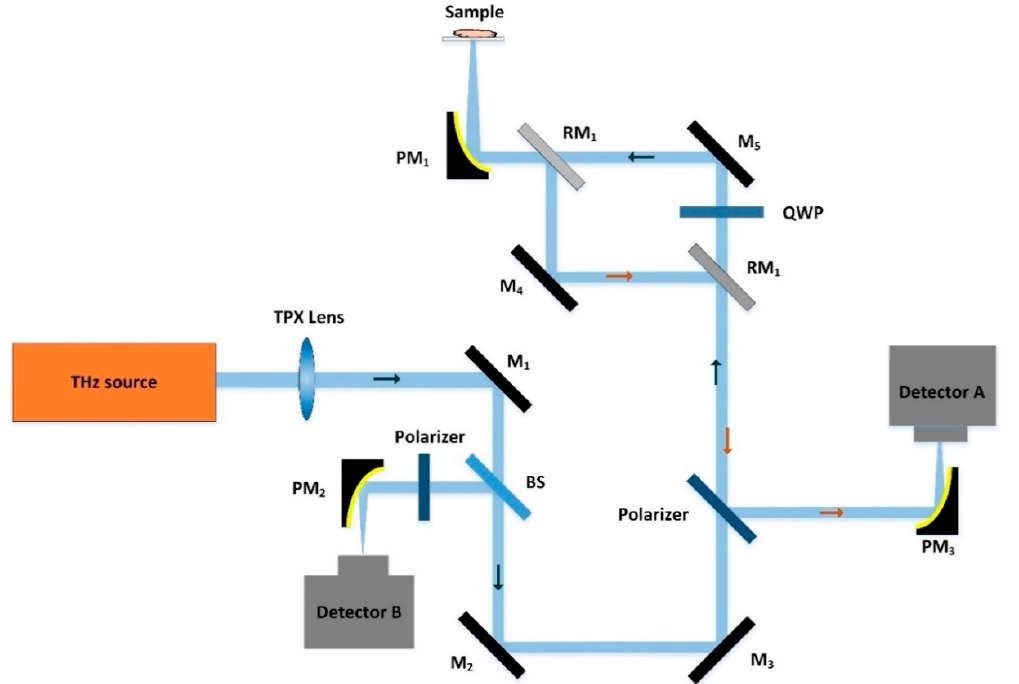
Figure 4. Schematic of optical setup for CW-THz CP and LP imaging.